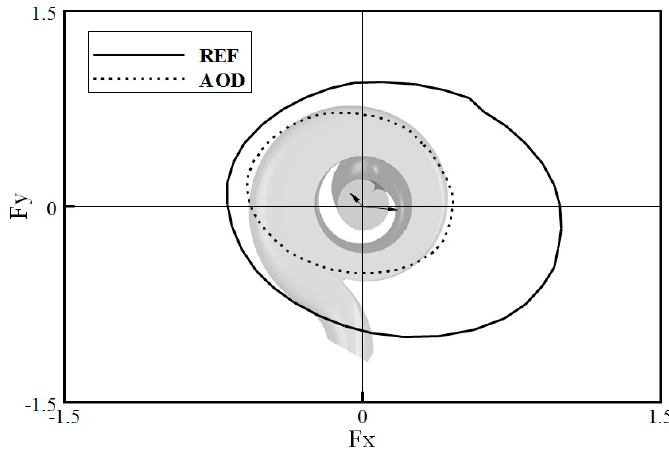
Figure 15. Sweep area distributions during one revolution of impeller.